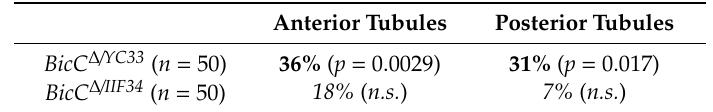
Table 1. Overall cyst reduction upon melatonin treatment of BicC mutants.